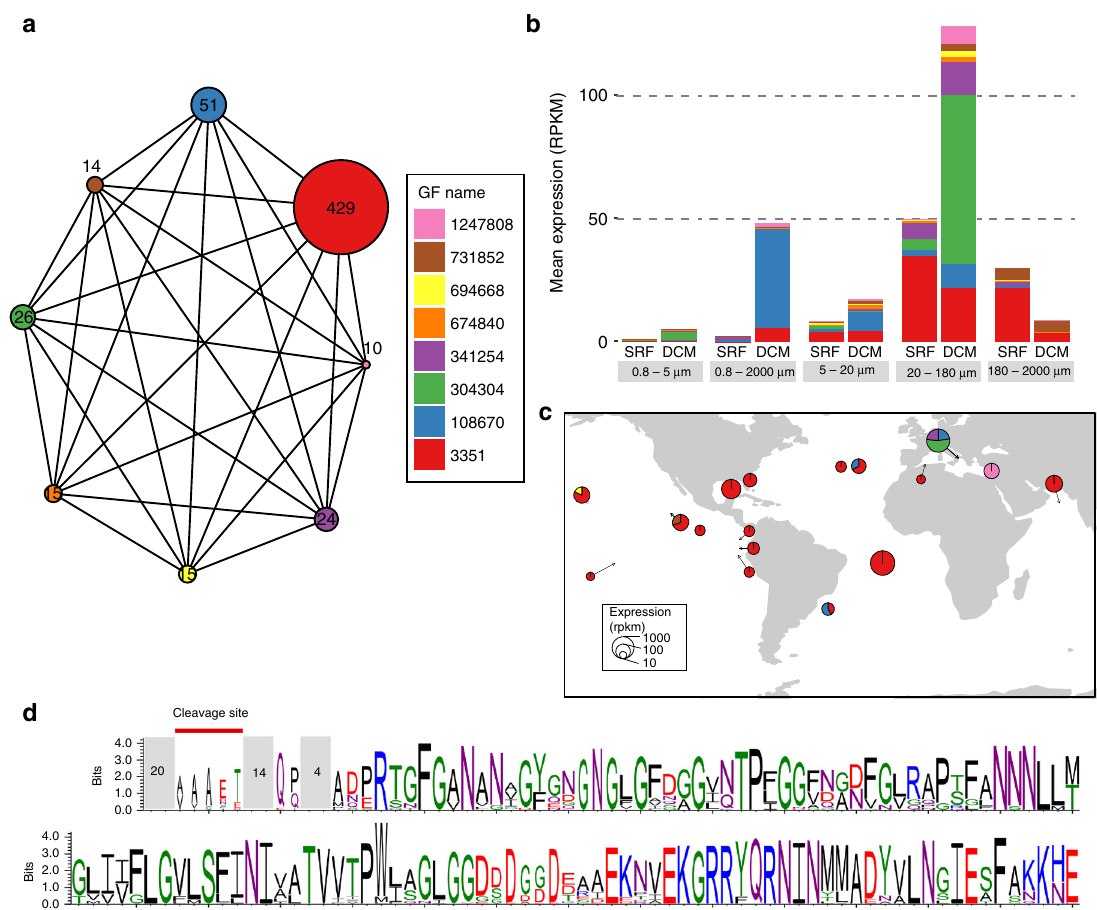
Fig. 5 New gene families expressed in 20 – 180 μ m size fraction. a Graph representation of the protein group number 14079 . Each GF of the protein group is represented by a node with a diameter proportional to the number of unigenes in the GF. Protein matches between GFs are represented by an edge. b Mean expression of GFs in different size-fractions and depths. Each color corresponds to a GF of protein group 14079 . c World map representation of protein group 14079 expression in the 20 – 180 µ m size fraction. SRF and DCM samples have been pooled. Circle diameters represent the relative expression of the protein group in RPKM. The contribution to expression of each GF is represented by the different colors. d Sequence logo of the multiple alignments of the protein group 14079 . 45 ORFs (153 amino acids in average) of protein group 14079 were aligned and positions with more than 50% of gaps were removed. Mean numbers of amino acids on unaligned regions of the protein are indicated in gray boxes. A signal peptide cleavage site, indicated on the left part of the sequence logo was predicted on 21